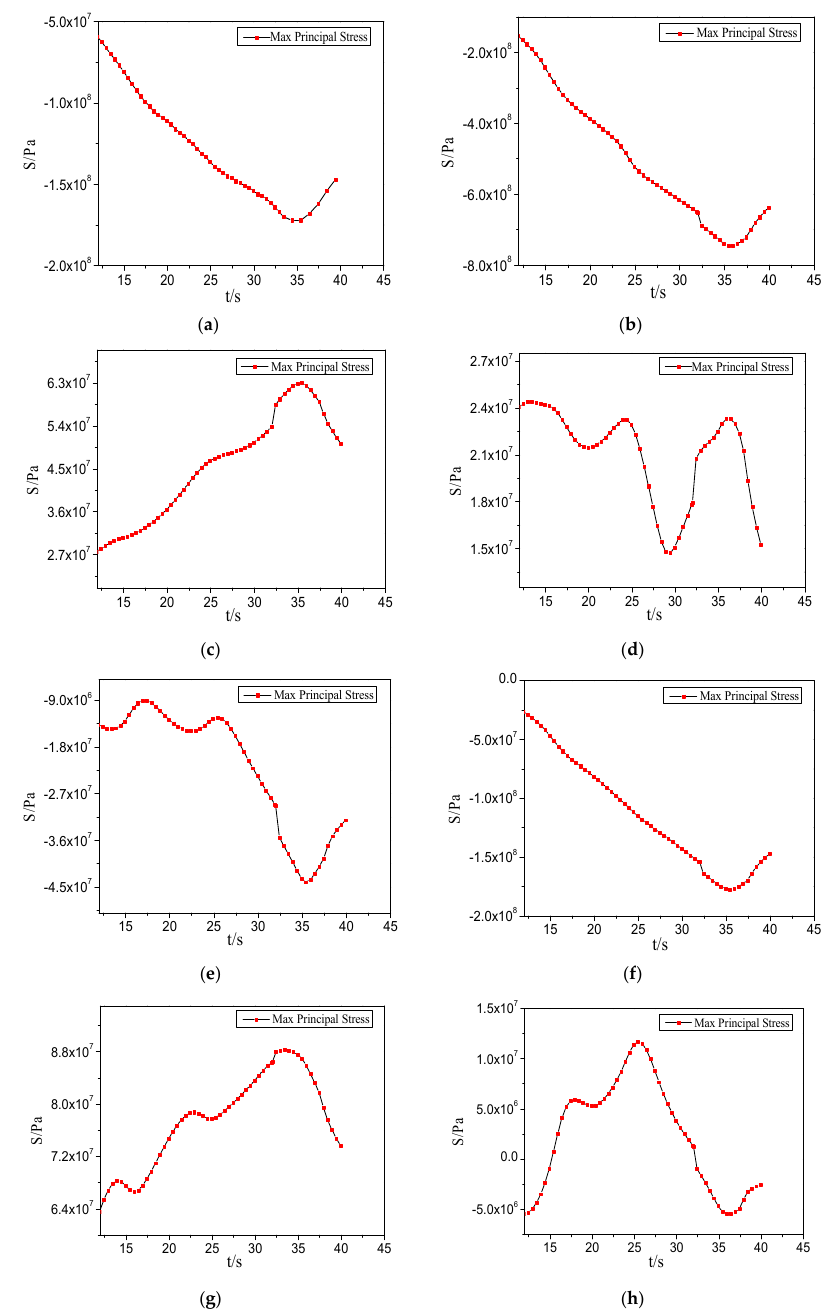
Figure 18. The stress curves of the elements near the crack tip in the heating process. ( a ) The stress curve of element ① ; ( b ) The stress curve of element ② ; ( c ) The stress curve of element ③ ; ( d ) The stress curve of element ④ ; ( e ) The stress curve of element ⑤ ; ( f ) The stress curve of element ⑥ ; ( g ) The stress curve of element ⑦ ; ( h ) The stress curve of element ⑧ .